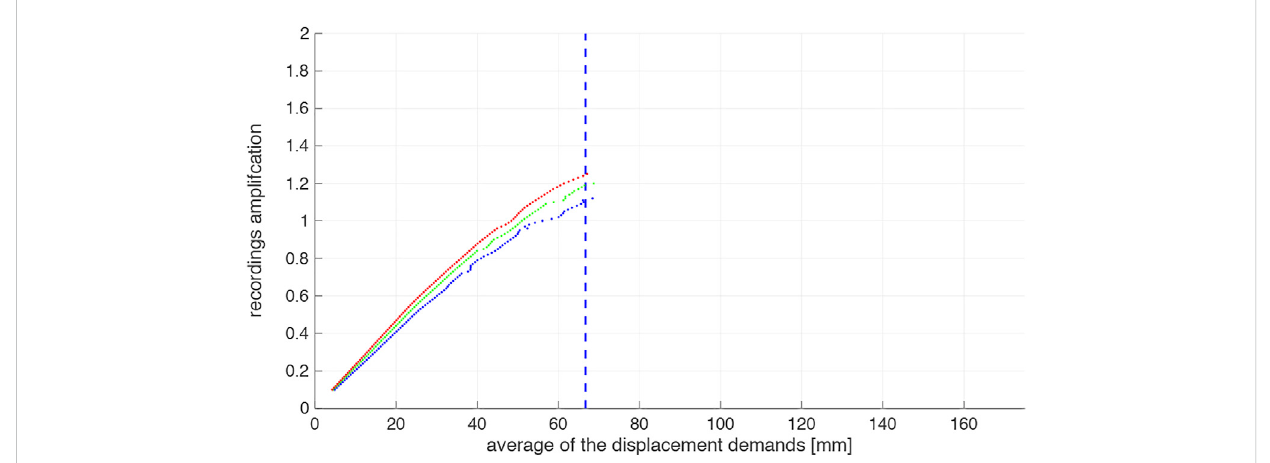
FIGURE 11 Non-linearcomputationswereperformedbyprogressivelyincreasingtherecordingamplitudesuntiltheultimatedisplacementwasreached(mean 12 TH > 0.4 · 2/3 · t w ). They were repeated for damping ratio values of 3%, 4% and 5%.